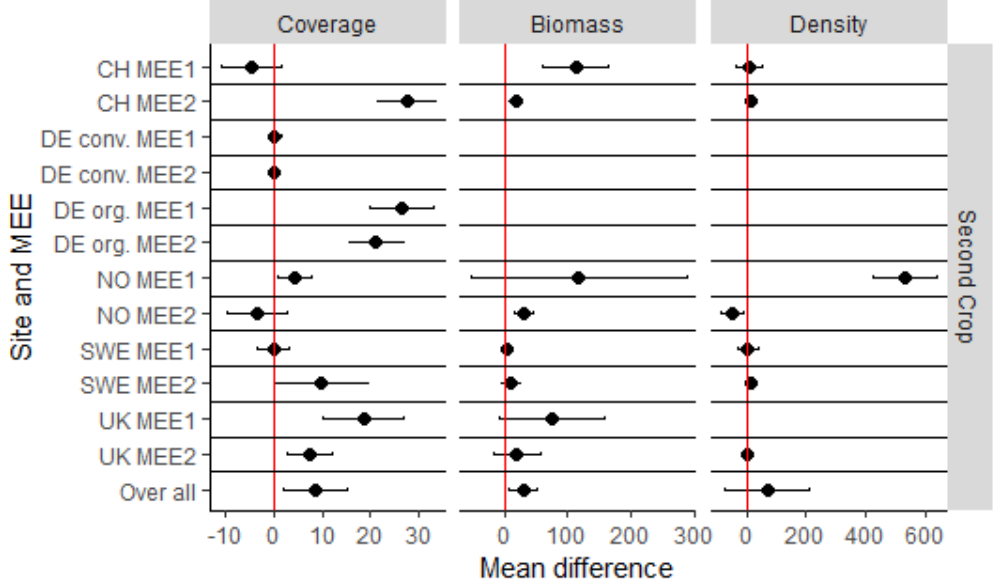
Figure 4. A meta-analysis of the e ff ect of the non-inversion tillage compared to inversion tillage on the weed abundance in the second main crop. Values are given as mean di ff erences. A negative mean di ff erence represents a lower weed abundance, and a positive mean di ff erence represents a higher weed abundance in non-inversion tillage treatment compared to the inversion tillage treatment. The points represent the estimated e ff ect and the lines the corresponding 95% confidence interval. Weed coverage is given in %-ground coverage, biomass in g m − 2 , and density in plants m − 2 . (MEE1 / MEE2—first / second round of the multi-environmental experiments).